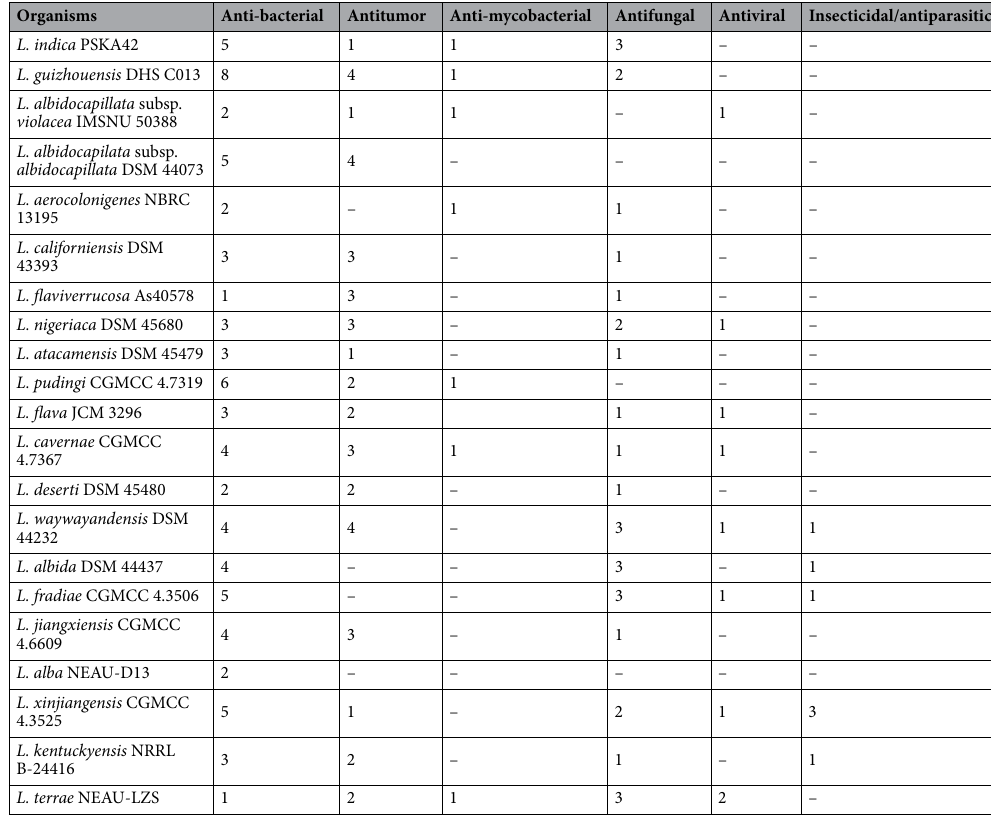
Table 2. Number of putative genetic clusters for bioactive compounds present in various Lentzea